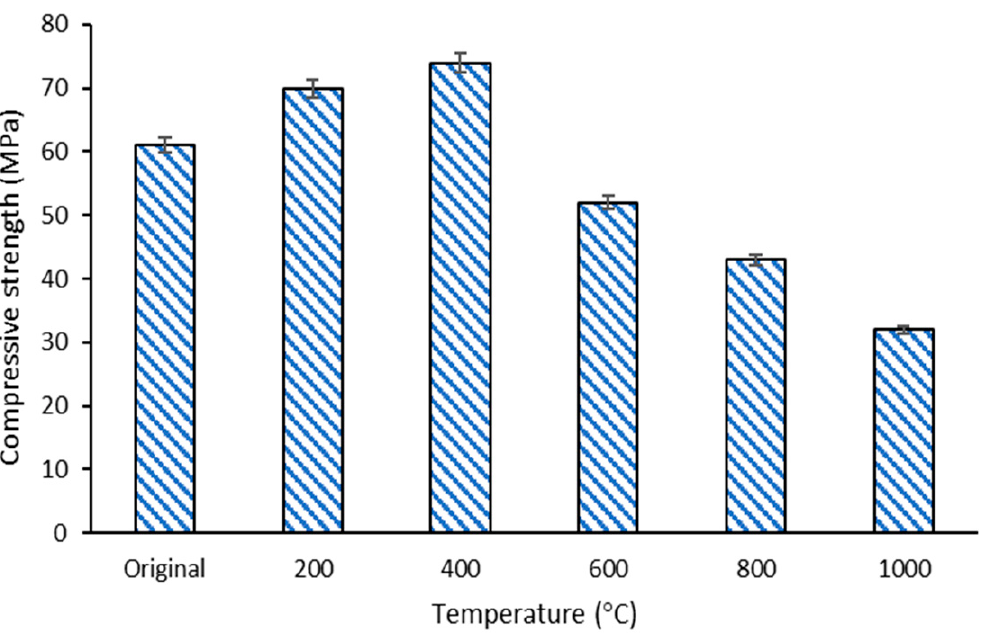
Figure 7. Compressive strength of dolomite/fly ash geopolymer composites before and after fire exposure at 200, 400, 600, 800, 1000 °C.